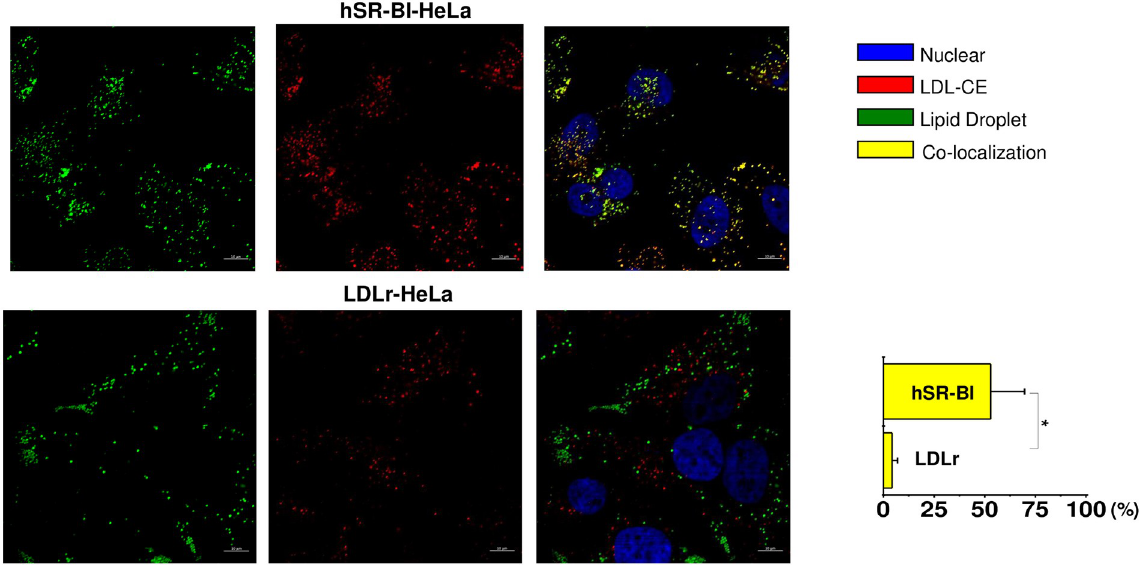
Fig 6. Co-localization of CE labeled LDL with neutral -stained LDs. HeLa cells were plated at 30% confluency on a glass cover slips and pre- incubated in serum free media for 24 hours prior to experiments. Labelled LDL were added to the media for 1 hour, washed and chased for 60 minutes in serum/lipoprotein free media. Cells were stained for LDs utilizing Neutral BODIPY as described in Materials and methods. The confocal images of -CE labeled LDL co-localized with neutral -stained LDs are demonstrated for various receptor expressing HeLa cells. The color code and extent of co-localization are shown in the right columns. The cell type is specified at the top of the figure. The bar corresponds to 10 μ m, � p < 0.001.